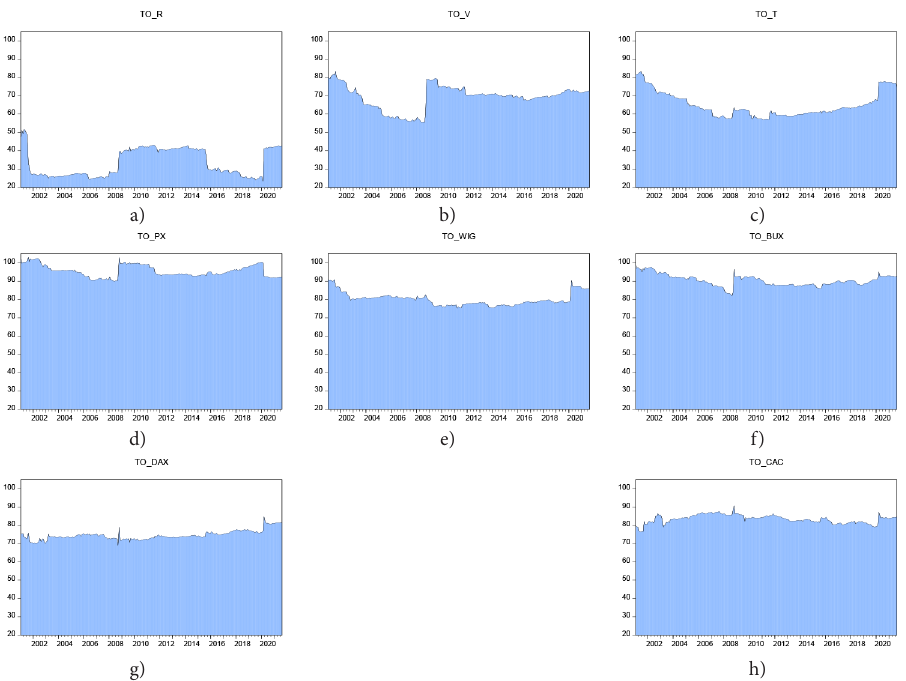
Figure 3. Directional volatility spillovers, to each stock market: a – Latvia; b – Lithuania; c – Estonia; d – Czech Republic; e – Poland; f – Hungary; g – Germany; h – France (source: results obtained by the